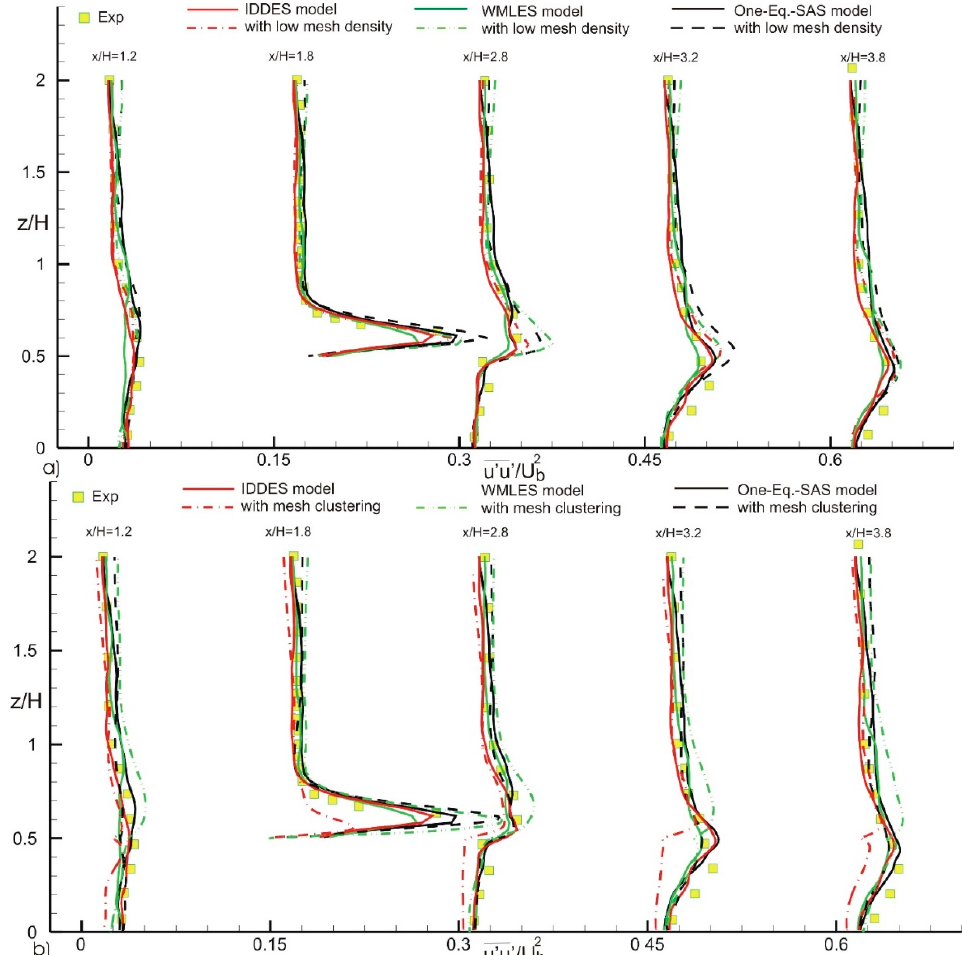
Figure 7. Effect of ( a ) mesh density, and ( b ) mesh clustering on the streamwise normalized Reynolds stress in the XZ plane cutting through the center of the cube at y/H = 0.5.